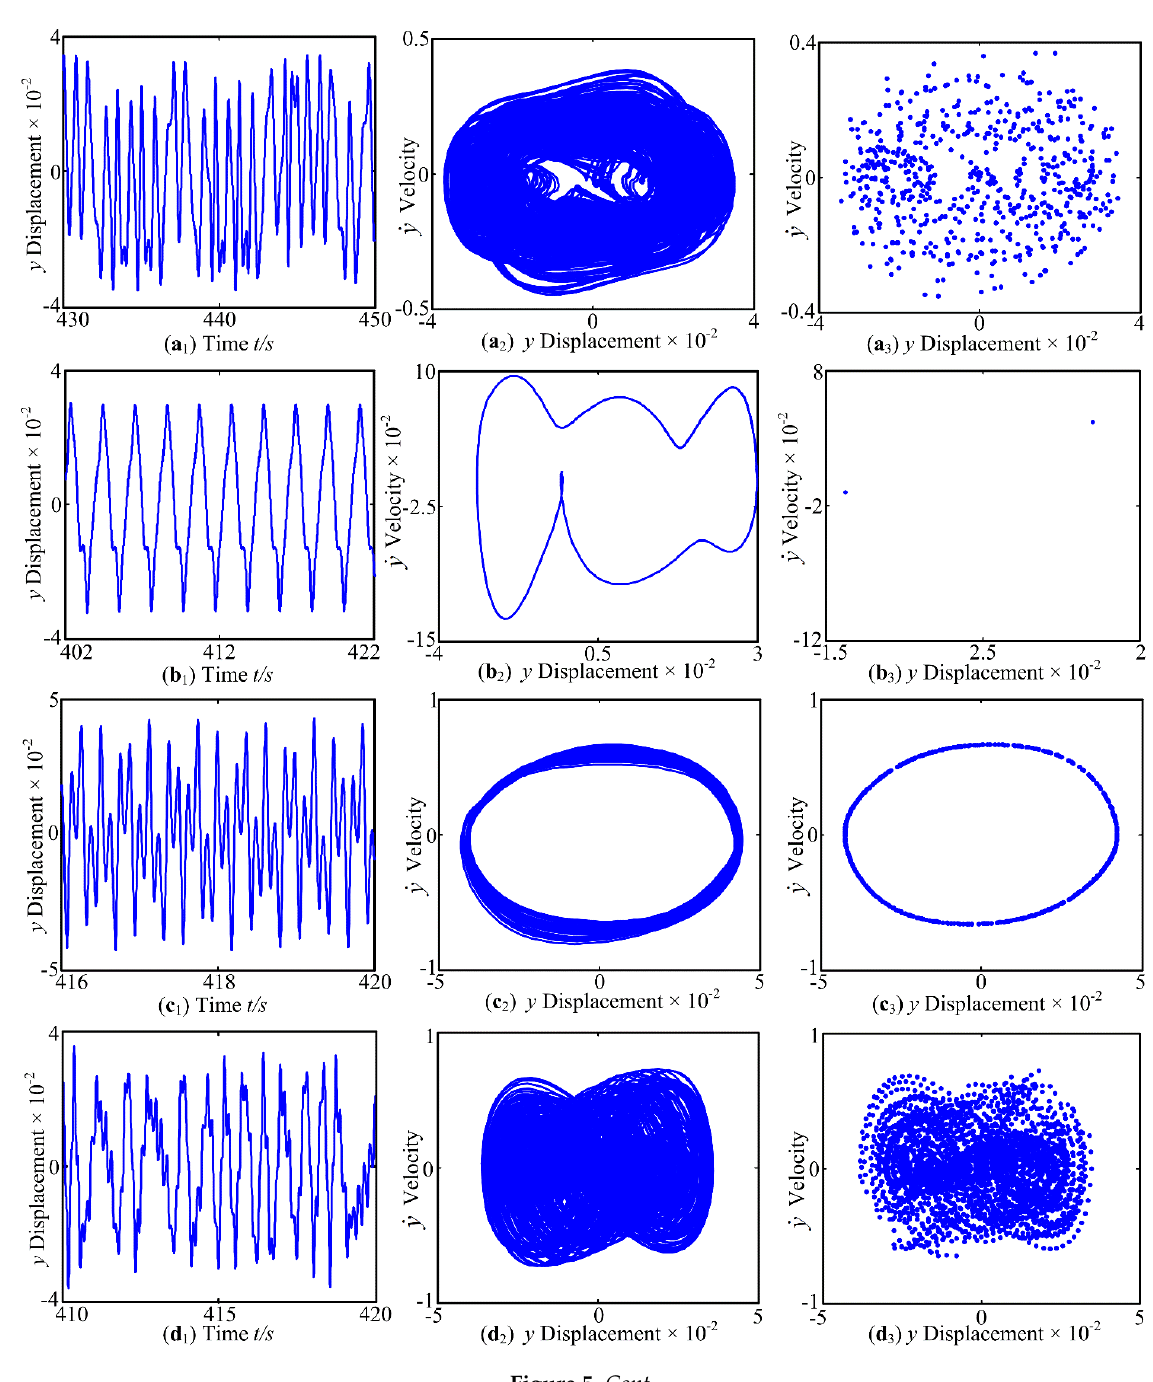
Figure 5(d 1 –d 3 ) by a waveform, phase diagram and Poincar é map. By increasing ω from 43.5 to 57.75, a series of inverse period-doubling bifurcations appears in the system, and the system response presents the phenomenon of period-doubling reverse bifurcation, the period number of vibration changes exponentially, and the chaotic motion of the system is transformed into periodic motion in the form of period-doubling reverse